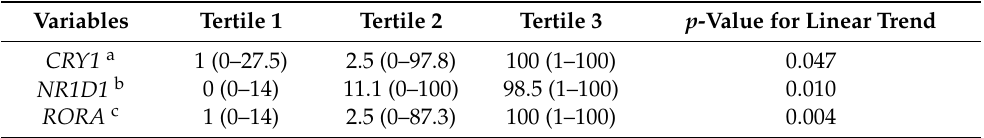
Table 4. The burden of atrial high-rate episodes according to tertile distribution on the basis of expression levels of CRY1 , NR1D1 , and RORA